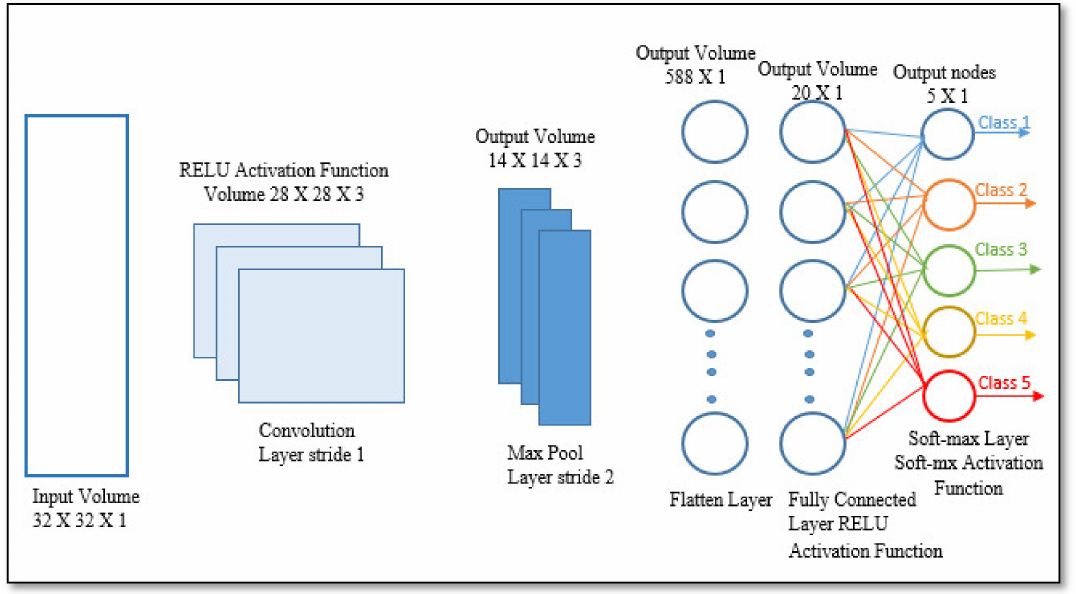
Figure 11. Fully connected Layer [8].